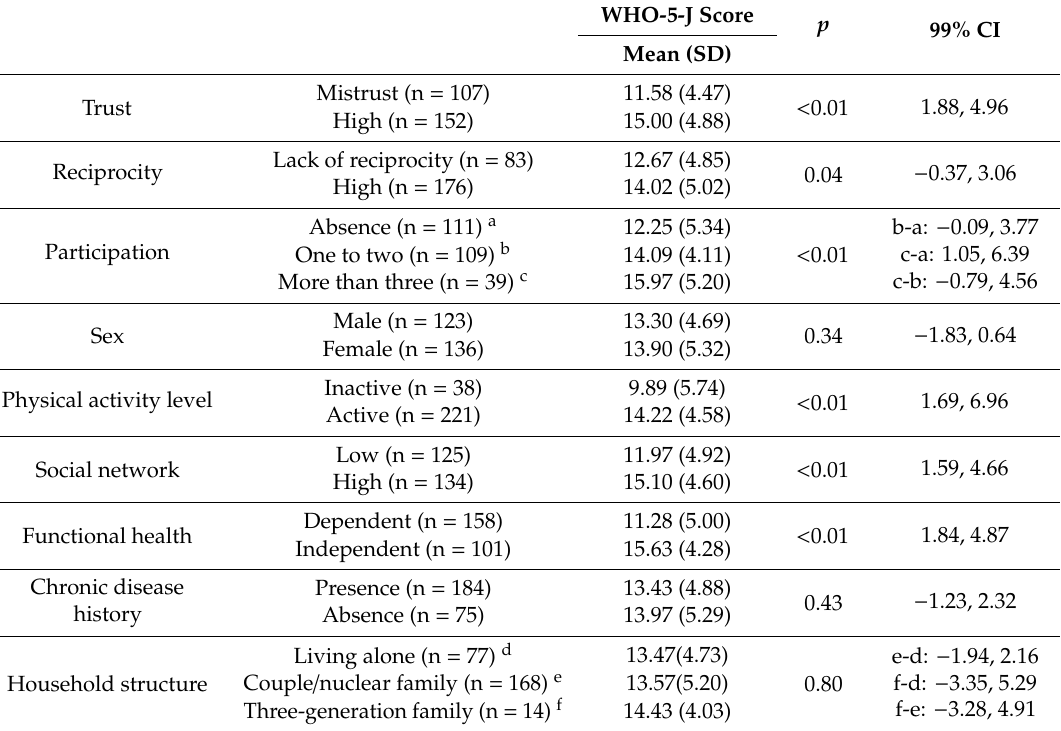
Table 3. The association between SWB and other variables (social capital and